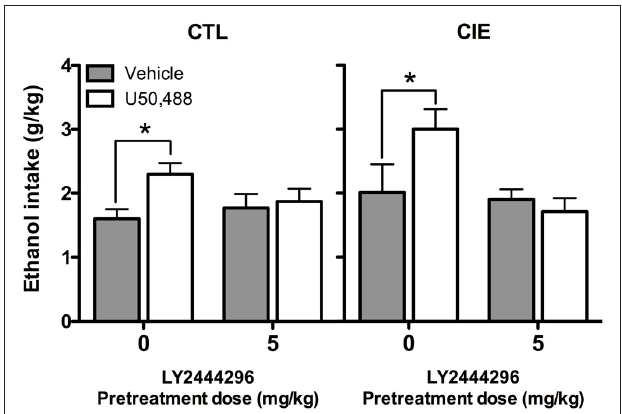
FIGURE 6 | Average ethanol consumption during final test week (g/kg) . For both CIE and CTL mice administered 5 mg/kg U50,488, pretreatment with the KOR antagonist LY2444296 blocked the increase in drinking observed in vehicle-treated mice (indicated by ∗